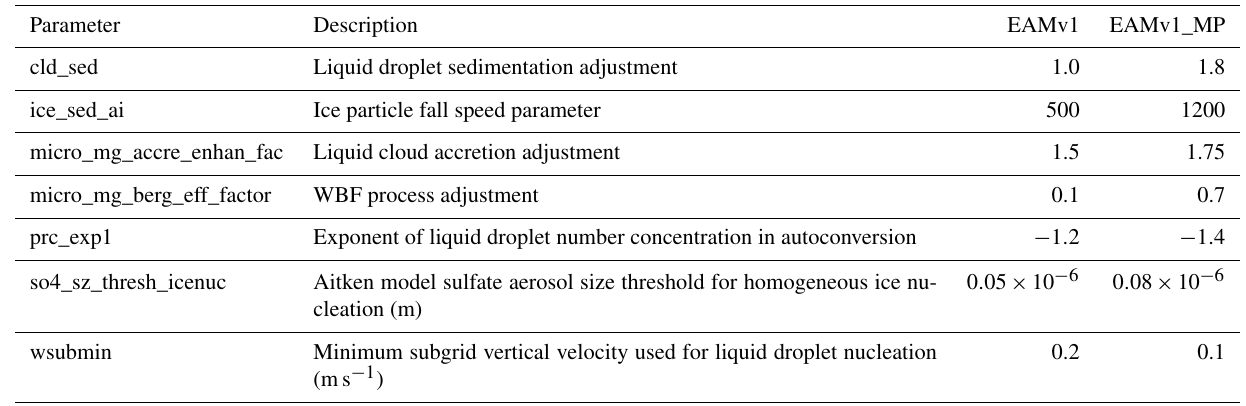
Table 3. Description of tunable parameters and their values in EAMv1 and EAMv1_MP. Parameter